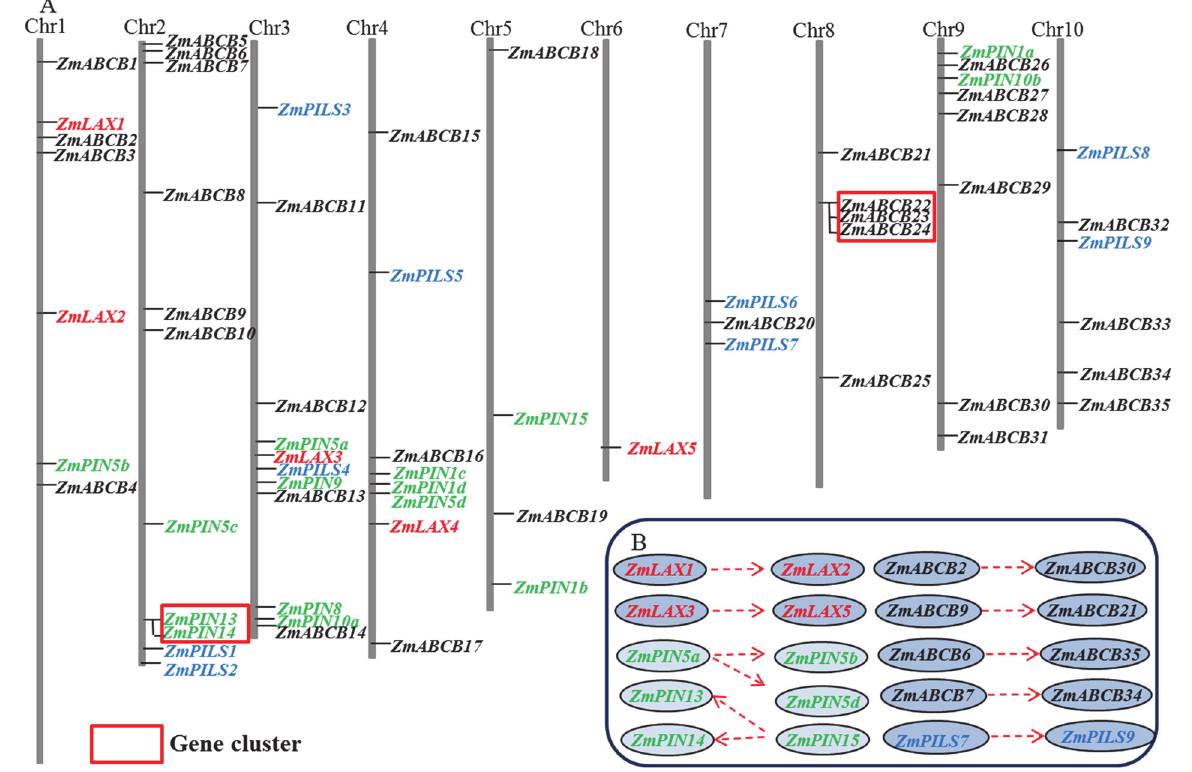
Fig 1. Chromosomal distribution and expansion patterns of maize auxin transporter encoding genes. (A) The genome visualization tool SyMAP Synteny Browser was employed (http://www.symapdb.org/) to analyze the maize genome. Maize chromosomes were arranged in blocks. Fifteen ZmPIN genes, nine ZmPILS genes, five ZmLAX genes and thirty-five ZmABCB genes were among ten chromosomes. ZmPIN , ZmPILS , ZmLAX and ZmABCB family genes are mapped by locus and the gene clusters were indicated by red boxes. (B) Gene segmental duplications were showed with dotted arrows.